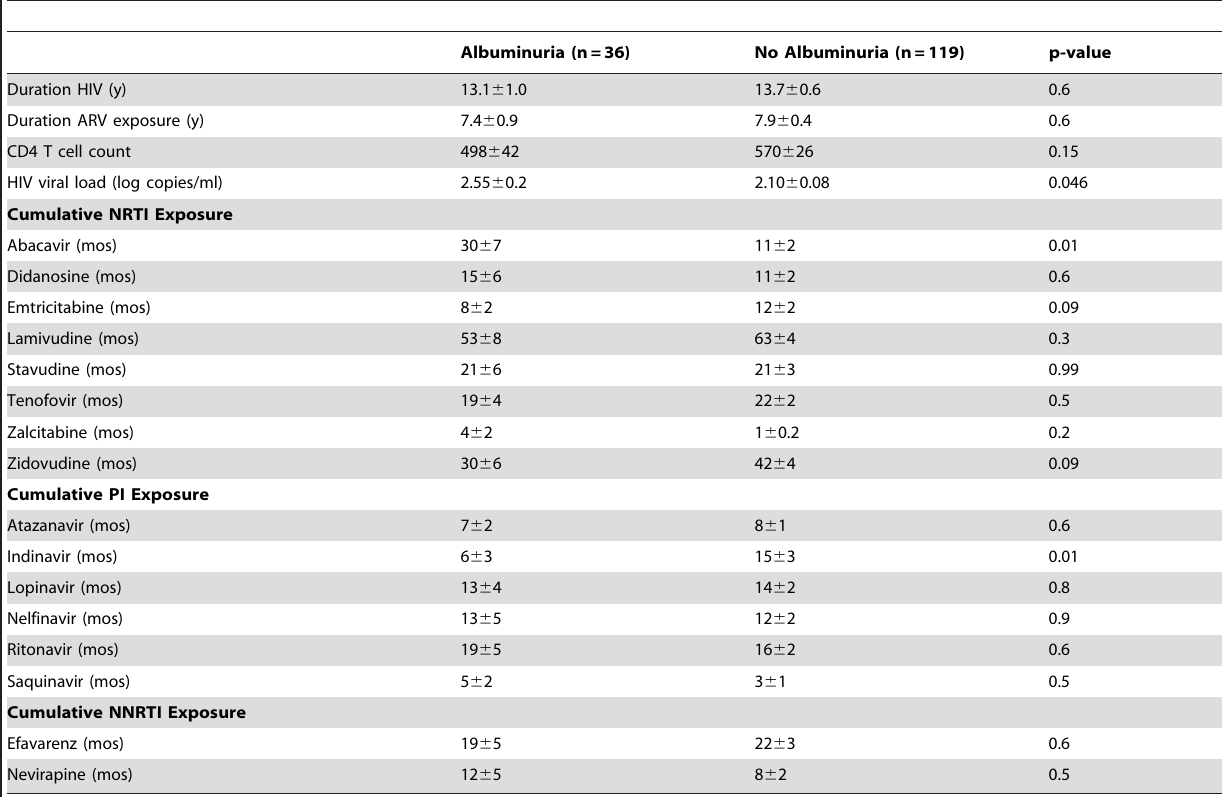
Table 2. Comparison of HIV-Related Characteristics and Cumulative ARV Exposure in HIV-infected Subjects with and without